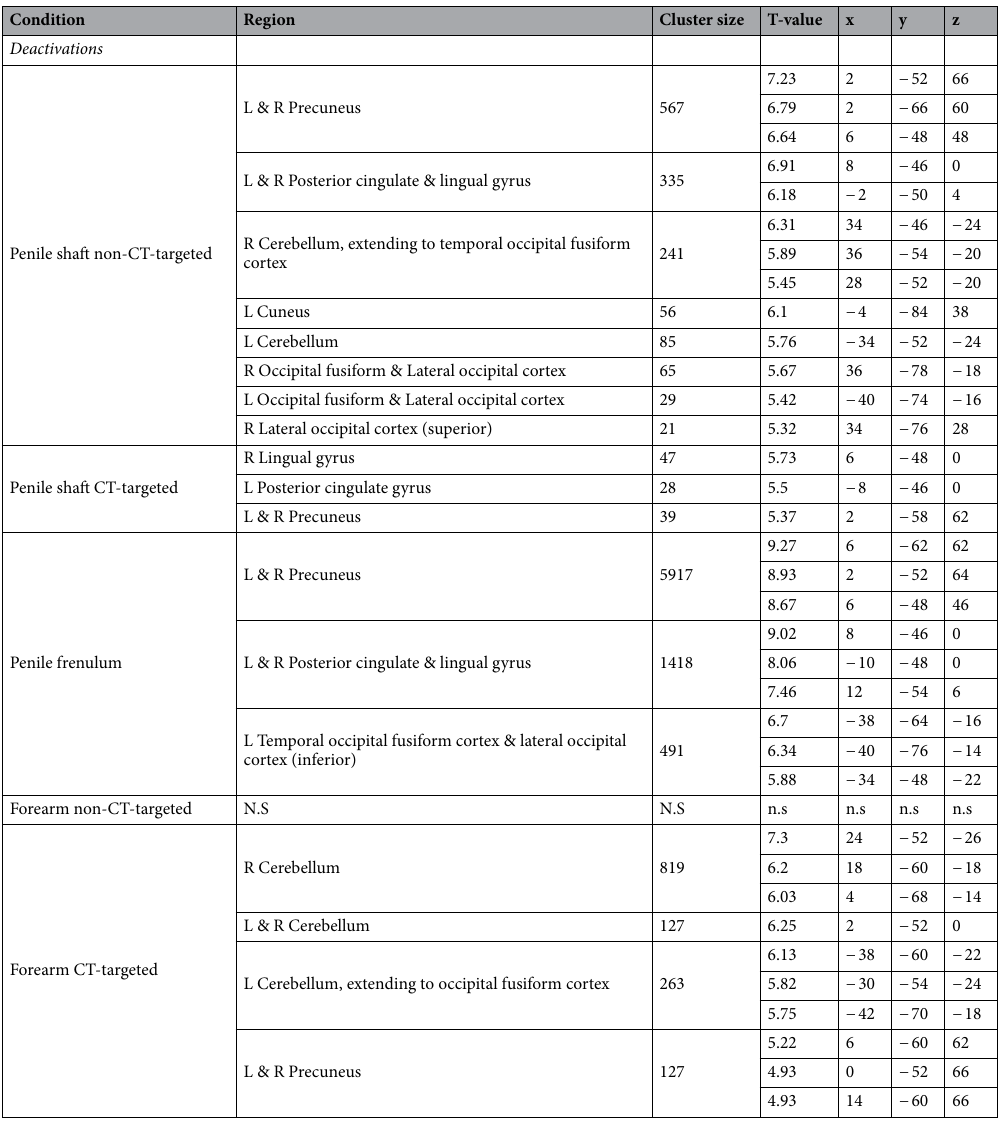
Table 1. Activated regions, MNI-coordinates, and T-statistics for each of the dynamic touch conditions versus baseline. Only activity with a peak-level p value < 0.05 (FWE-corrected) and minimal cluster size of (k = 20) is reported. Regions were defined with the Harvard–Oxford cortical atlas. Abbreviations: R, right hemisphere; L, left